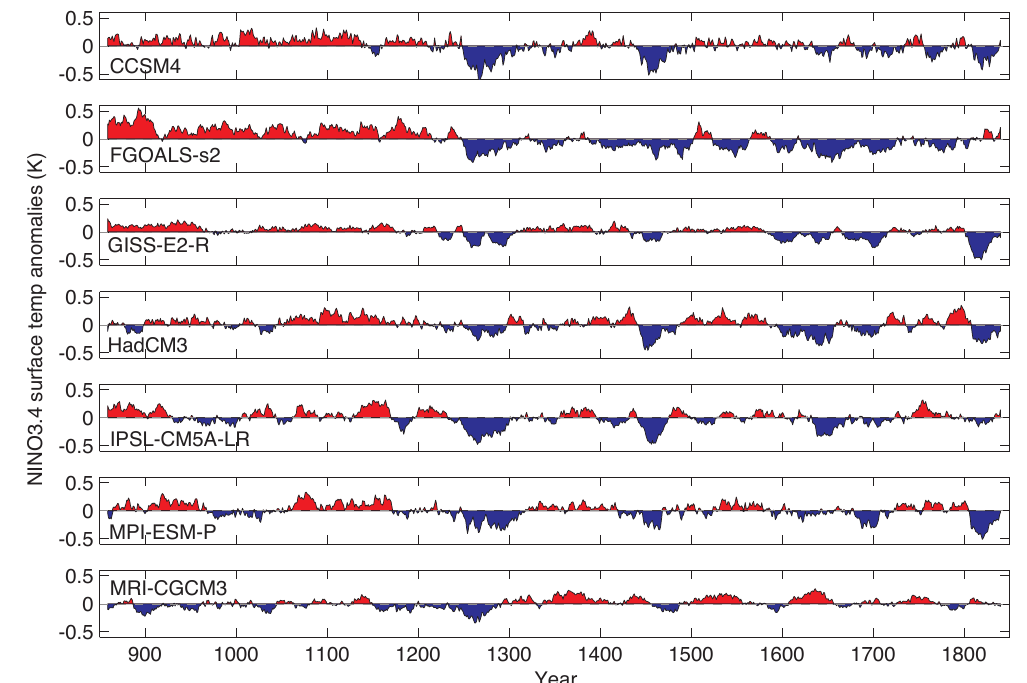
Figure 5. Running annual-mean surface temperature anomalies (K) over the NINO3.4 region (5 ◦ N–5 ◦ S, 170–120 ◦ W) for Last Millennium simulation for each model. Red/blue shading highlights departures from each model’s long-term mean. Running means were calculated using a 240-month triangle